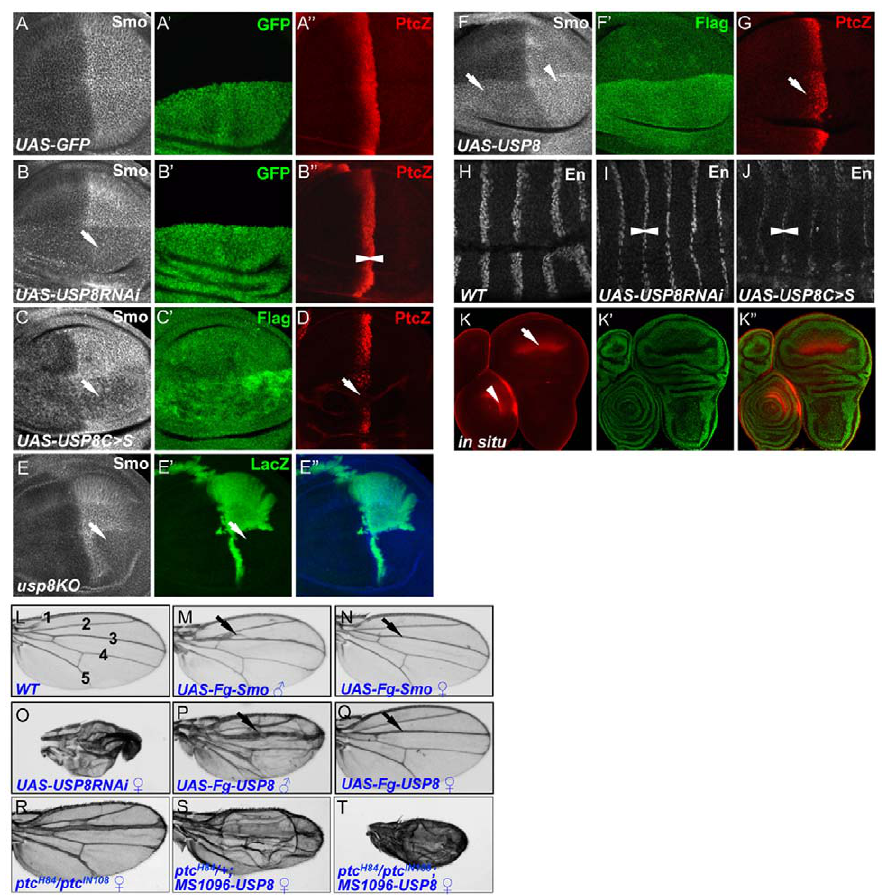
Figure 6. The function of USP8 in regulating Smo accumulation in the Drosophila wing. (A–A 0 ) A wing disc expressing UAS-GFP by the dorsal compartment-specific ap -Gal4 was stained for Smo and ptc-lacZ to show the wild-type staining. (B–B 0 ) A wing disc from flies co-expressing UAS-USP8RNAi and UAS-GFP by ap -Gal4 was stained for Smo and ptc-lacZ. The arrow in (B) indicates the attenuated accumulation of Smo and the arrowheads indicate the down-regulation of ptc-lacZ. GFP indicates that ap -Gal4 is expressed in the dorsal compartment cells of the wing disc. (C–D) Wing discs expressing UAS-Flag-USP8C . S by MS1096 Gal4 were stained for Smo (grey in C), Flag (green in C 9 ), and ptc-lacZ (red in D). The arrow in (C) indicates inhibition of Smo accumulation. The arrow in (D) indicates attenuated ptc-lacZ expression. Note that the level of Gal4 driven by MS1096 is higher in the dorsal compartment than in the ventral compartment. (E–E 0 ) A wing disc bearing usp8KO homozygous clones, which were marked by the lack of b -gal staining, was immunostained for Smo. The arrow in (E) shows the reduced Smo accumulation in P-compartment cells. (F–G) Wing discs expressing UAS-Flag-USP8 by MS1096 Gal4 were stained for Smo (grey in F), Flag (green in F 9 ), and ptc-lacZ (red in G). Arrow and arrowhead in (F) indicate the elevated Smo and arrow in (G) indicates the expansion of ptc-lacZ. (H) A wild-type embryo was stained for En. (I–J) Embryos expressing USP8RNAi or USP8C . S by act5C -Gal4 were immunostained for En. The arrowheads indicate the reduction and contraction of En expression. (K–K 0 ) USP8 expression patterns in wing and leg discs (arrow and arrowhead, respectively) were determined by FISH with a DIG-labeled mRNA probe against USP8. Rhodamin (red) was used to detect the DIG-labeled mRNA, and DAPI (green, was false colored in green to provide better contrast) was used to label the nuclei. All wing imaginal discs shown in this study were oriented with anterior on the left and ventral on the top. (L) A wild-type adult wing showing interveins 1–5. (M–N) Wings from either male or female flies expressing Flag-Smo by MS1096 Gal4. The arrow in (M) indicates the overgrowth structures between Vein 2 and 3, and the arrow in (N) indicates the thickened Vein 3 caused by the overexpression of Smo. (O) A wing from flies expressing USP8RNAi by MS1096 Gal4. (P–Q) Wings from male or female flies expressing Flag-USP8 by MS1096 Gal4. Arrows indicate the wing overgrowth structure or the thickness of Vein 3. Of note, males of the same genotype have more severe phenotypes than females, presumably due to dosage compensation of the X-chromosome carrying the MS1096 -Gal4. (R) A wing from ptc mutant flies indicates the overgrowth between Vein 2 and 3. (S–T) Adult wings from flies expressing Flag-USP8 by MS1096 Gal4 in the background of ptc mutants. In the ptc heterozygous or homozygous background, USP8 induced more severe wing overgrowth, which is indicated by wing blisters (S) or sick wings (T). function studies indicate that USP8 is required for Smo accumulation. In addition, a gain-of-function experiment showed that the overexpression of USP8 caused an accumulation of Smo in both A- and P-compartment cells (Figure 6F) and caused anterior expansion of ptc-lacZ in cells that received Hh (Figure 6G).